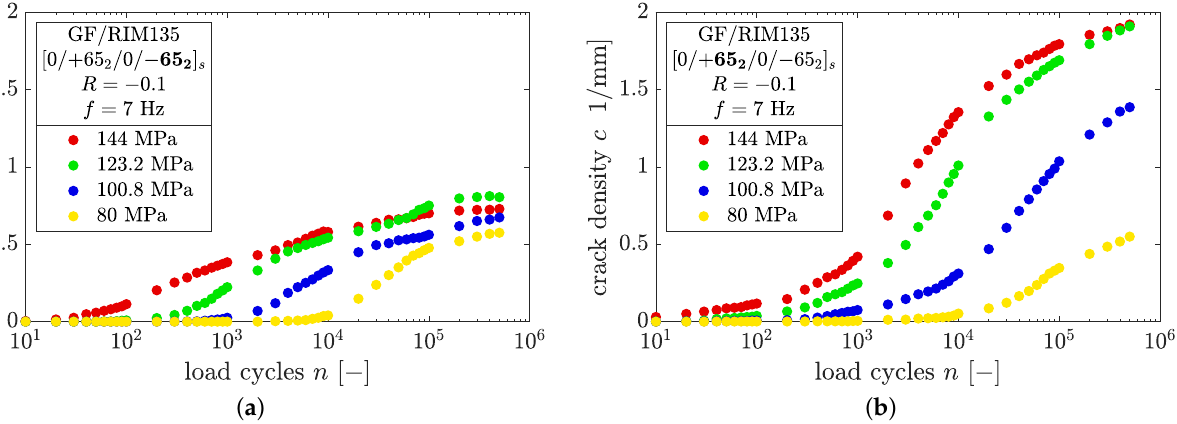
Figure A5. Results of the crack counting procedure for [ 0/ + 65 2 /0/ − 65 2 ] s -laminates for ( a ) thick and ( b ) thin layers at R = − 0.1.